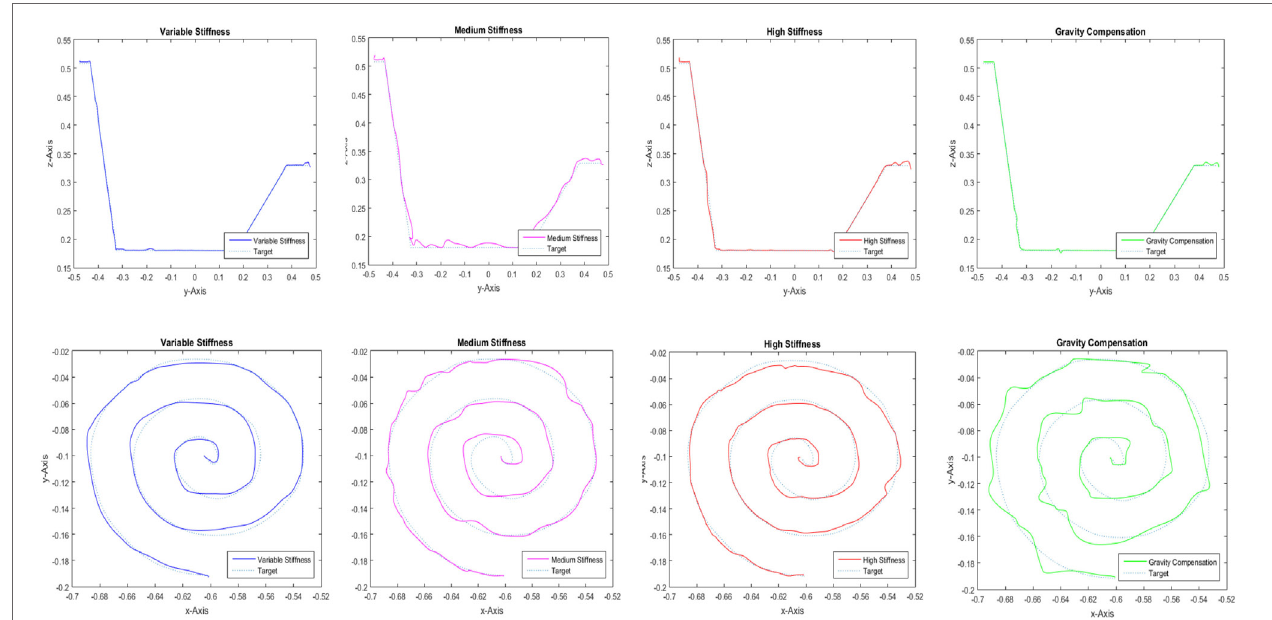
FigUre 4 | Performance of participant 23, while using different control modes to finish the contour­following and drawing